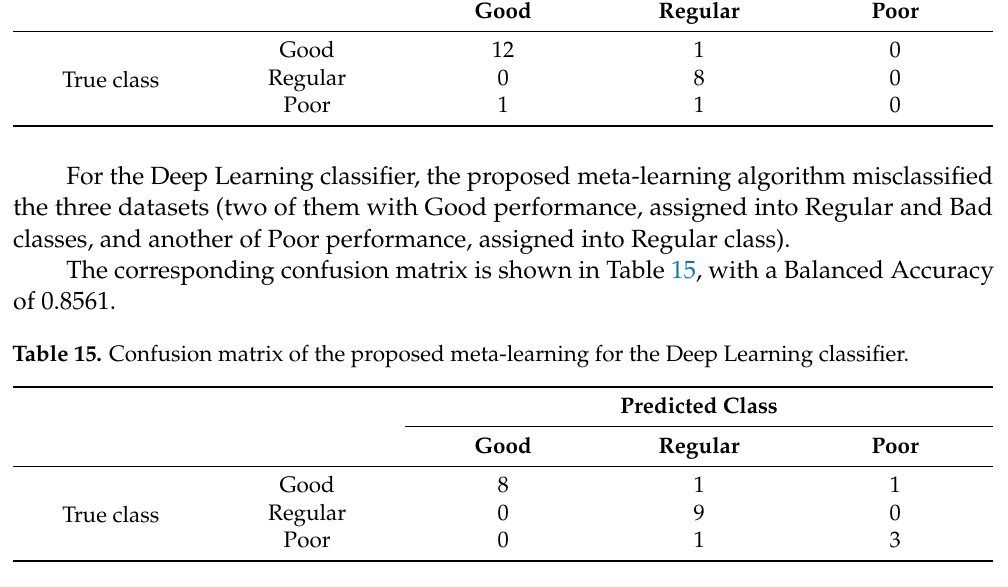
Table 14. Confusion matrix of the proposed meta-learning for the Logistic classifier. Predicted Class Good Regular Poor Good 12 1 0 Regular 0 True class 0